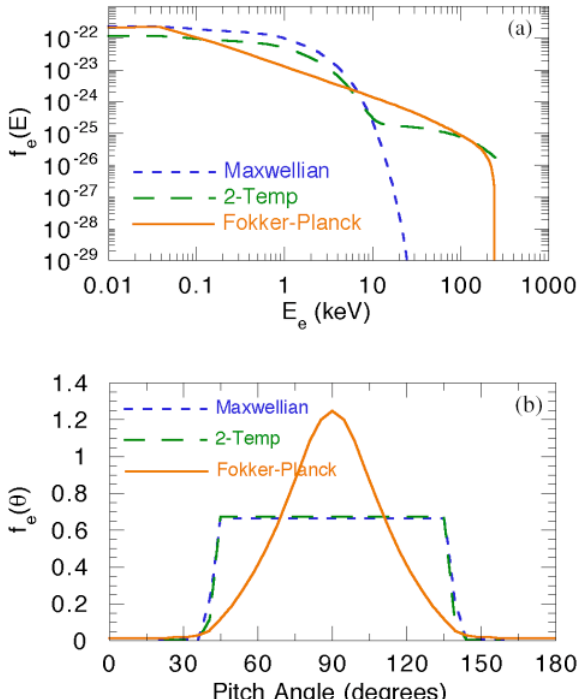
FIG 3. (Color) Electron distribution functions corresponding to the CSDs of Fig. 2. (a) is the distribution integrated over pitch angle f e (cid:2) y (cid:3) and (b) is the distribution integrated over velocity f e (cid:2) u (cid:3)